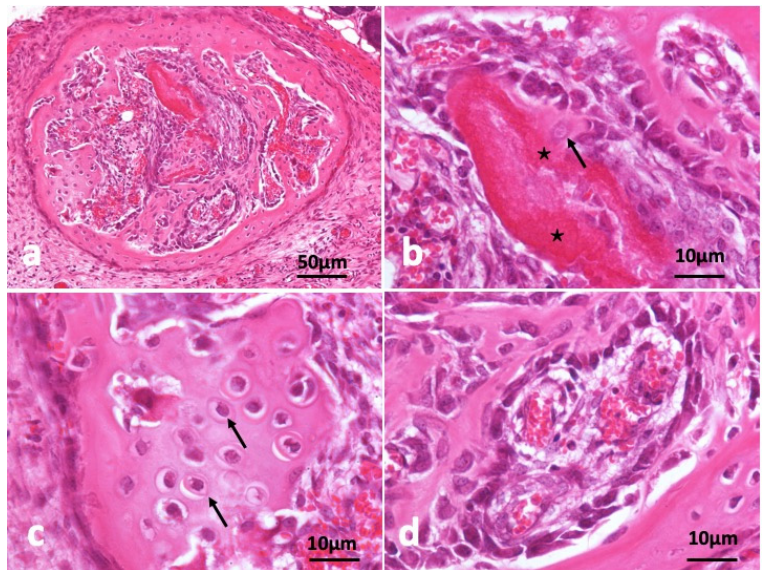
Figure 4. Histological images of CGF/BMP-2 membrane on periosteum of skull at 14 days. ( a ) CGF/BMP-2 induced bone like eggshell, ( b ) Osteoblasts near residue of strongly eosin-stained CGF ( ⋆ ) representing acellular, arrow indicating young osteocyte, ( c ) Arrow indicating osteocytes like hypertrophic chondrocytes, ( d ) Immature bone with cuboidal osteoblast lining near capillary (HE). 2.5. Concentrated Growth Factor (CGF) Membrane Alone onto Periosteum of Skull of Head Skins The CGF alone did not induce bone. Undifferentiated mesenchymal cells proliferated,